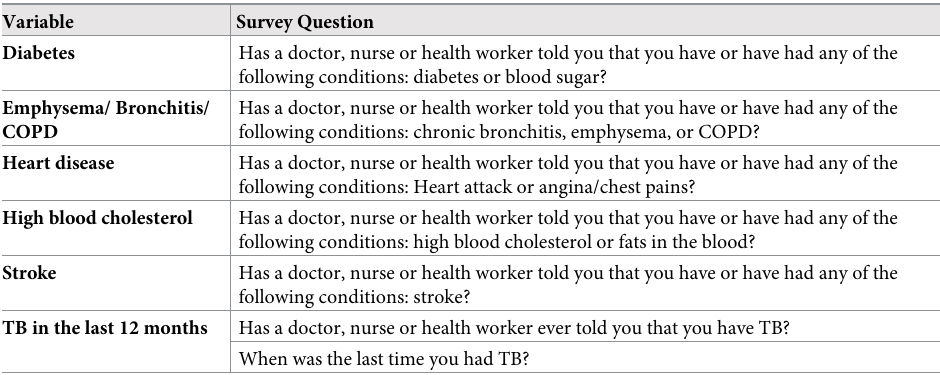
Table 1. Survey questions on self-reported